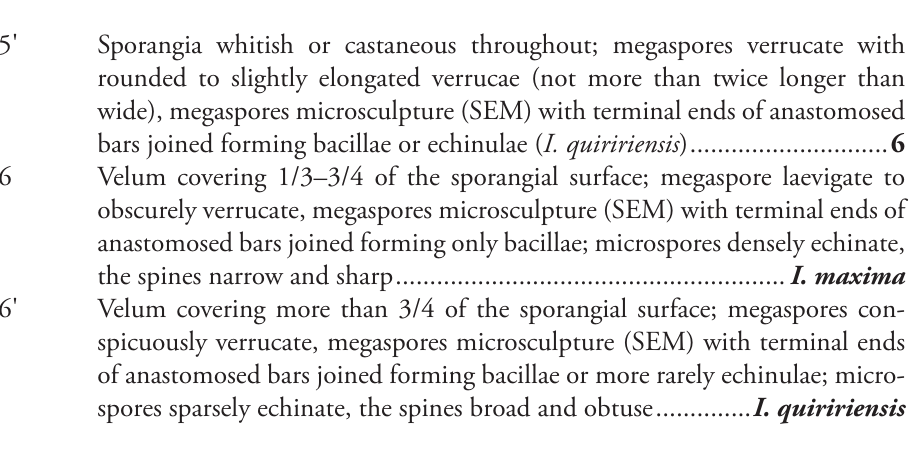
Figure 8. SEM images of the microspore of Isoetes weberi (Herter 95840, US), I. quiririensis (Pereira 635, UPCB), I.maxima (Pereira 631, UPCB). A–C Microspore of I. weberi A Proximal view B Equatorial view C Distal view D–F Microspore of I. quiririensis D Proximal view E Equatorial view F Distal view G–I Microspore of I. maxima G Proximal view H Equatorial view I Distal view. All scale bars = 2 µm.